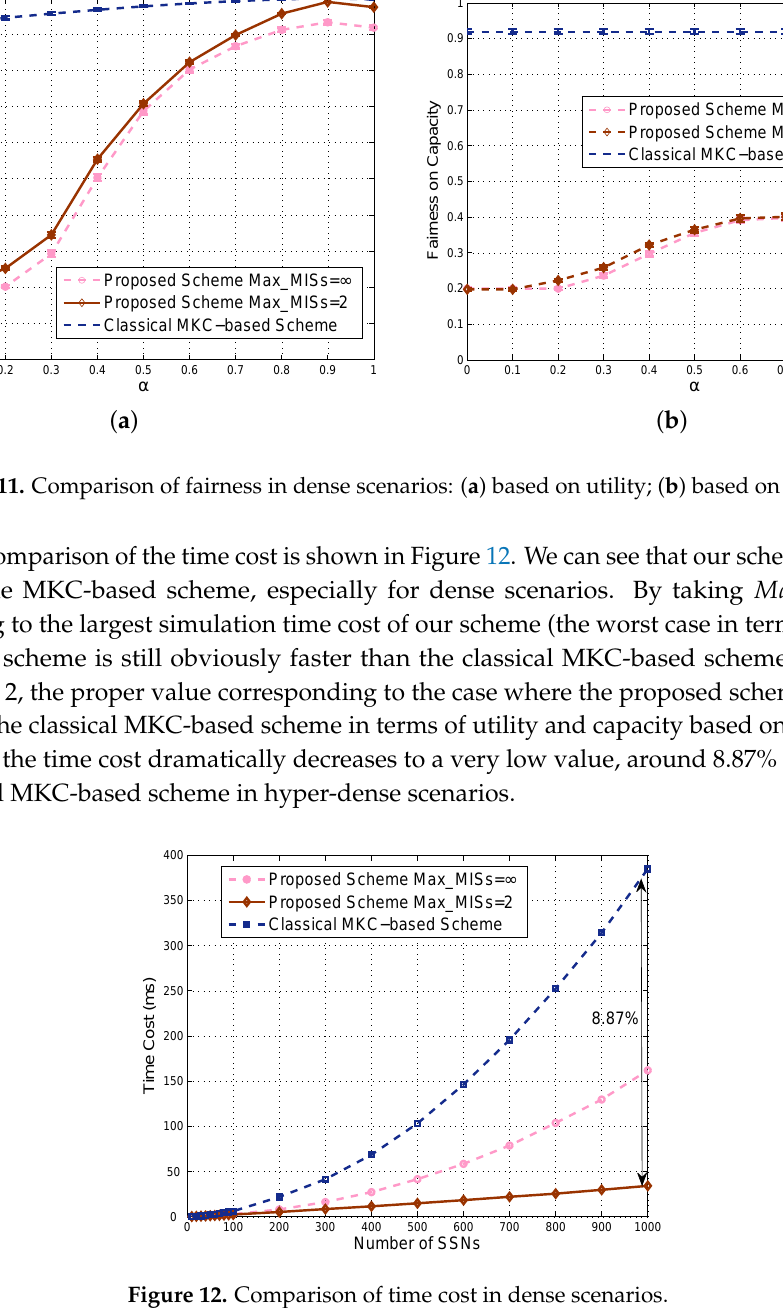
Figure 12. Comparison of time cost in dense